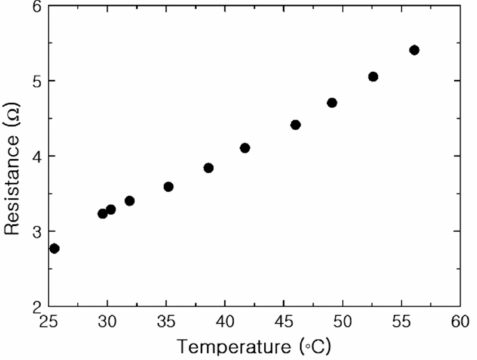
Figure 8. Resistance of the PTC-SHT according to temperature.